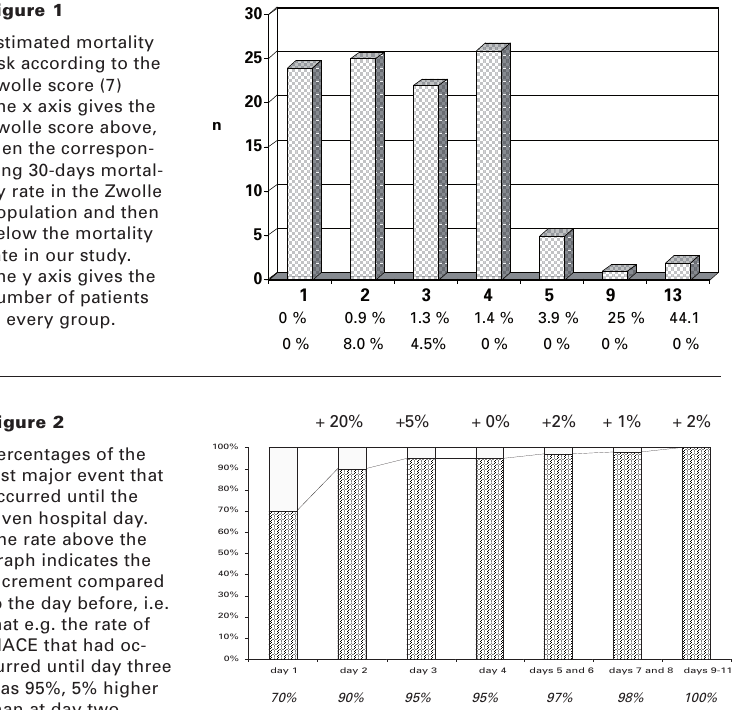
Percentages of the last major event that occurred until the given hospital day. The rate above the graph indicates the increment compared to the day before, i.e. that e.g. the rate of MACE that had oc- curred until day three was 95%, 5% higher than at day